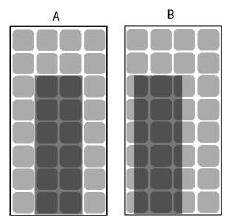
Figure 10. Shadow on photovoltaic module of same size and shape but in different location. In figure 10 shadows of same size but on different position will cause different shadow effect. Because for module A 12 cells are completely shaded and for module B 6 are completely shaded and 12 are partially shaded, which means 18 cells are affected in module B.